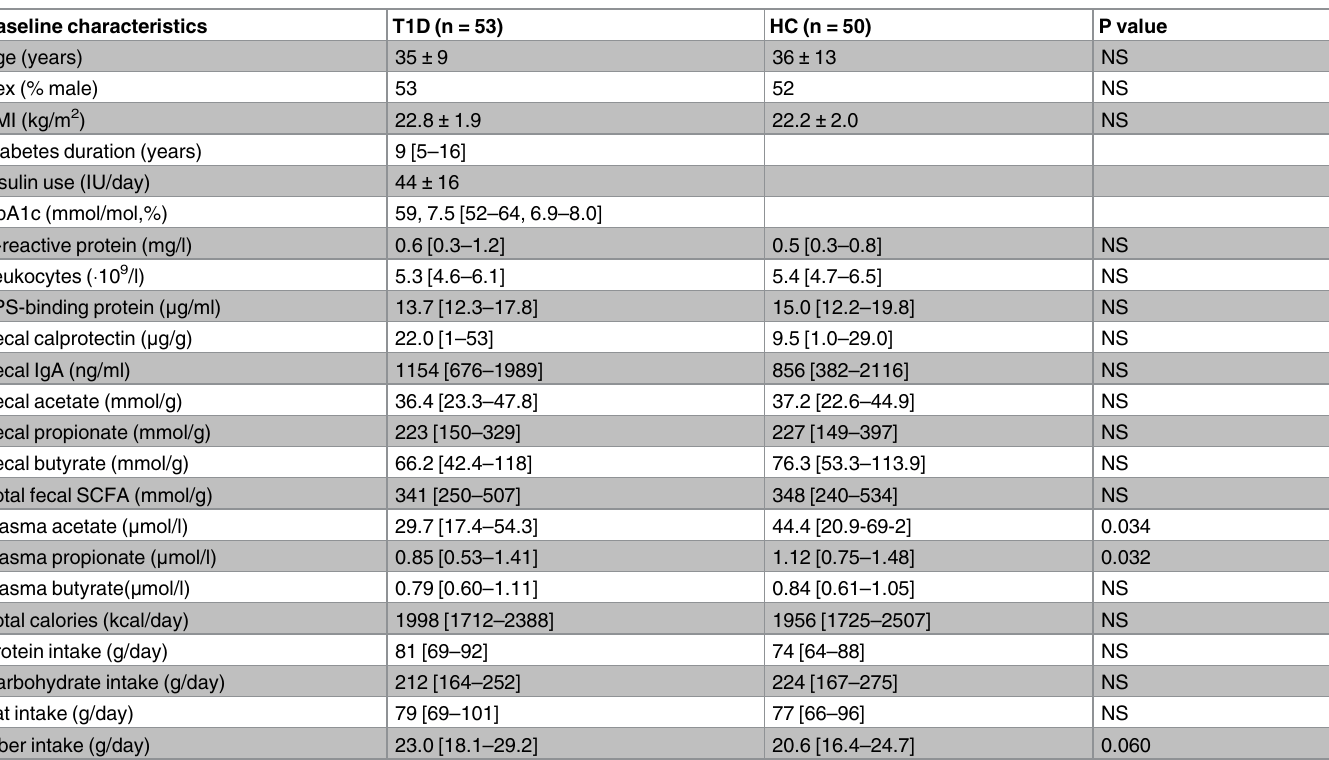
Table 1. Baseline characteristics.